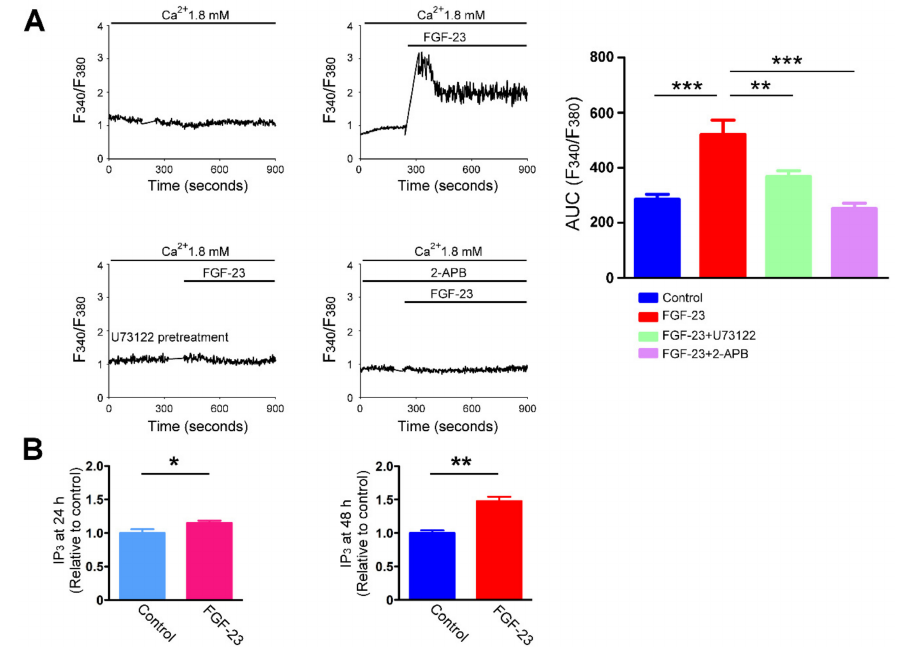
Figure 6. Fibroblast growth factor (FGF)-23 stimulates inositol 1,4,5-trisphosphate (IP 3 ) production in cardiac fibroblasts. ( A ) Representative fura-2 fluorescence tracings (left panel) indicates intracellular Ca 2+ transient of an individual cardiac fibroblast in the presence of extracellular Ca 2+ (1.8 mM) without and with pretreatment of U73122 (a phospholipase C inhibitor, 1 µ M for 5 min) or 2-APB (an IP 3 inhibitor, 50 uM added 5 min prior to recording), followed by the addition of FGF-23 (25 ng/mL). The changes of intracellular Ca 2+ concentrations (right panel) in cardiac fibroblasts ( n = 12 cells) were quantified as the area under the curve (AUC) values of fluorescence intensities (F340/F380). ( B ) Average data of intracellular IP 3 levels in cardiac fibroblasts without and with FGF-23 (25 ng/mL) treatment for 24 h (left panel, n = 5) and 48 h (right panel, n = 5). Data were expressed as a fold change relative to control. * p < 0.05, ** p < 0.01, *** p < 0.005.